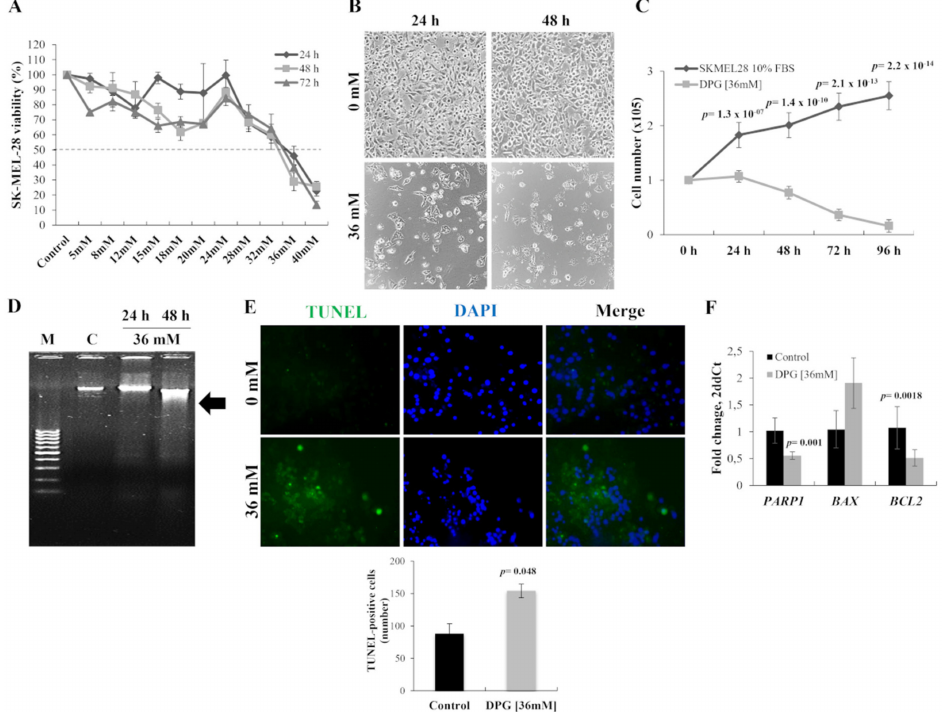
Figure 1. Dipotassium glycyrrhizinate (DPG) affects cell proliferation and apoptosis in a melanoma cell line. ( A ) DPG inhibits cell viability of SK-MEL-28 cells treated with different DPG concentrations for 24, 48, and 72 h by (4,5-dimethylthiazol-2-yl)-2,5-diphenyl tetrazolium bromide (MTT) assay